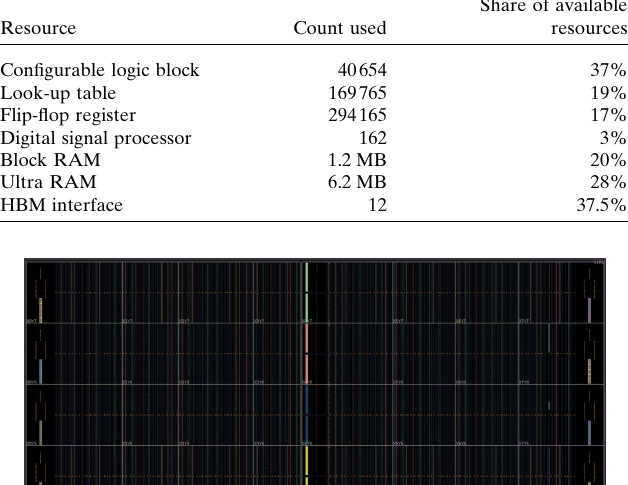
Share of available